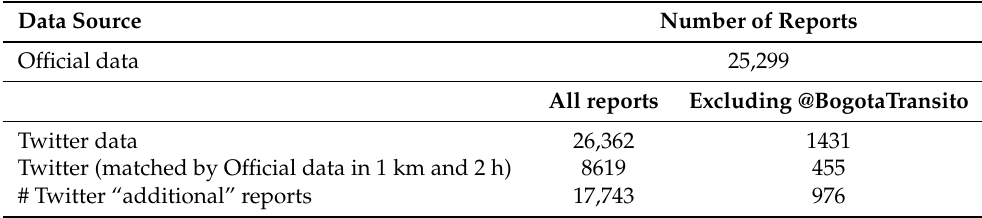
Table 16. Number of accidents reported according to data